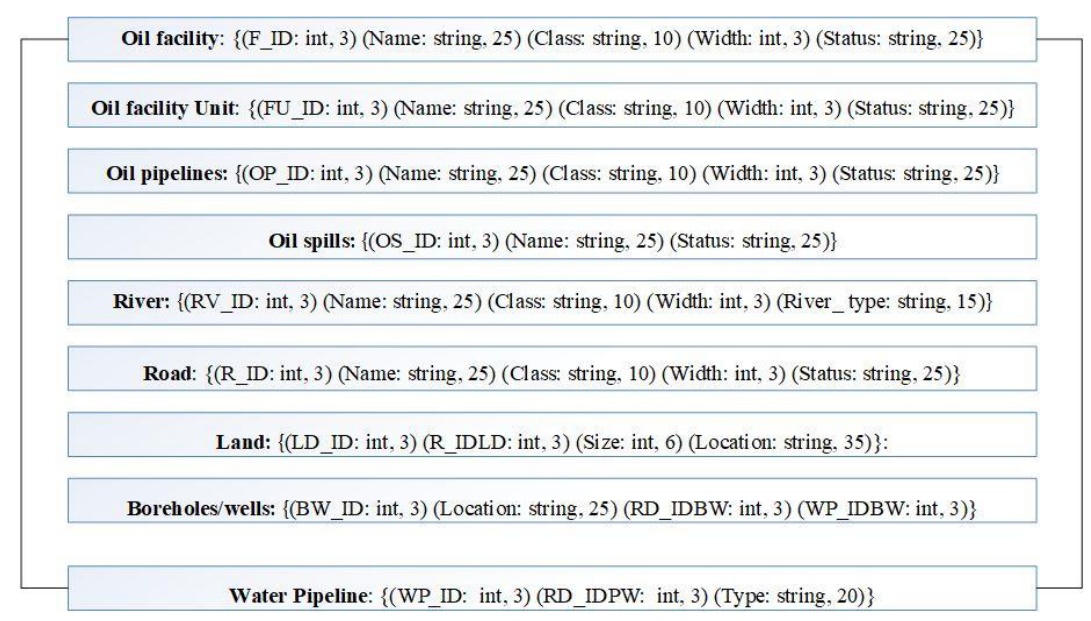
Figure 9. Physical design application of oil spills pollution affecting water